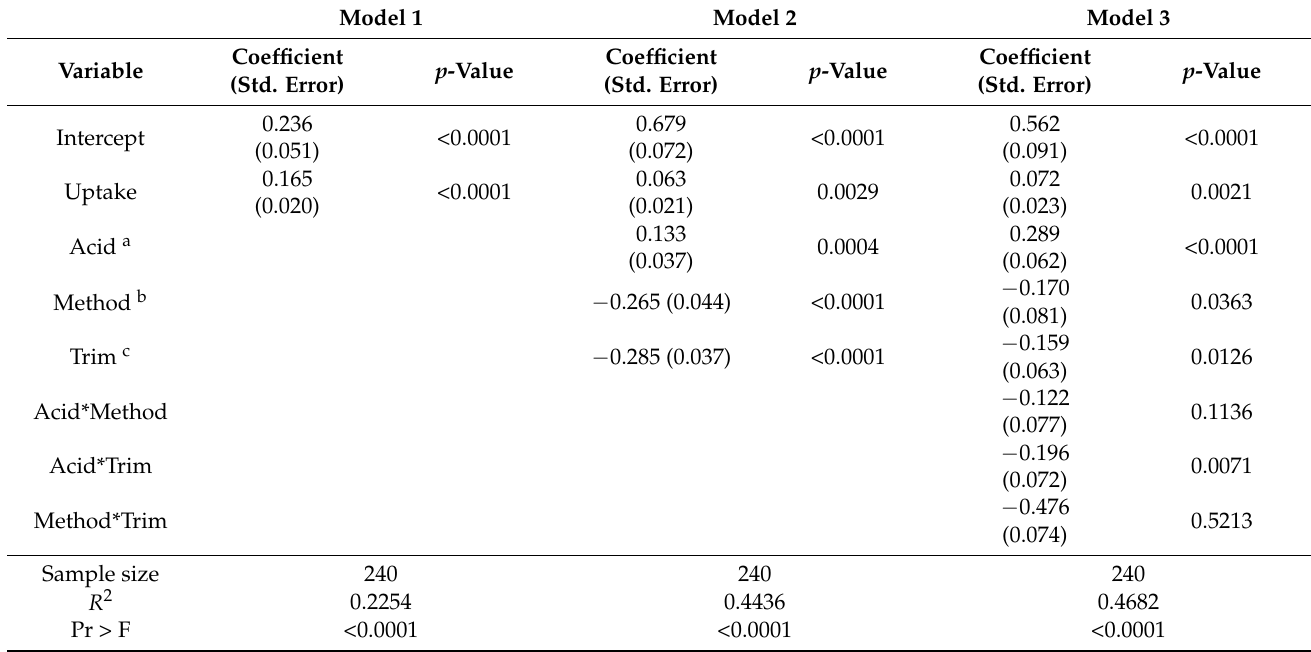
Table 1. Estimated linear regression coefficients for Shiga-toxin producing Escherichia coli reduction ( n = 240) with main effects and interactions between explanatory